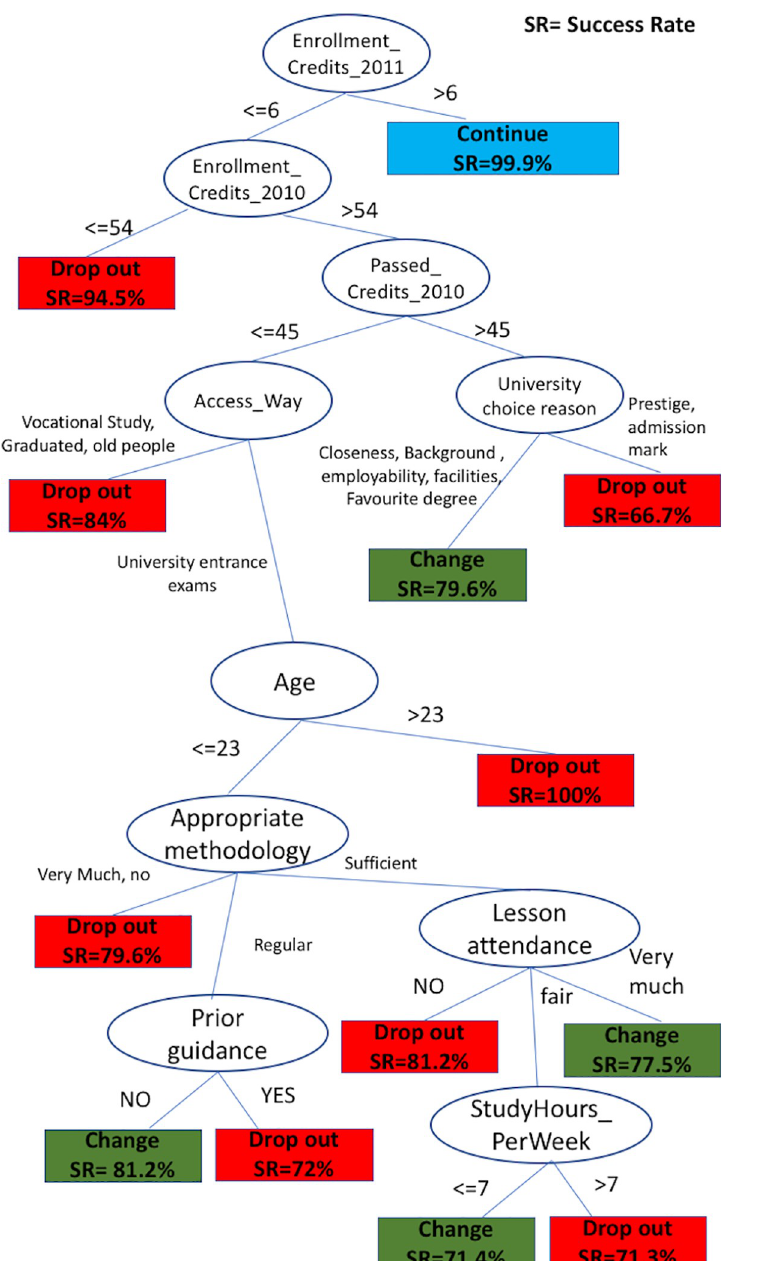
Fig 7. Decision tree to predict drop out or transfer